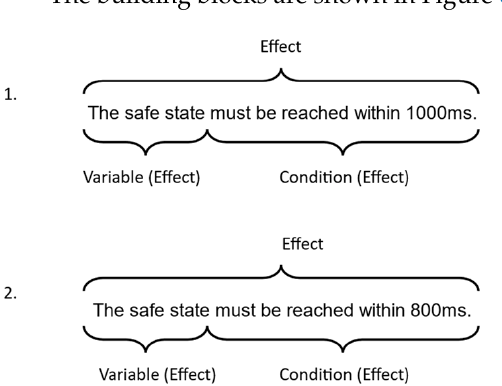
Figure 6. Building blocks for a Simplex Subaltern contradiction, consisting of two requirements.